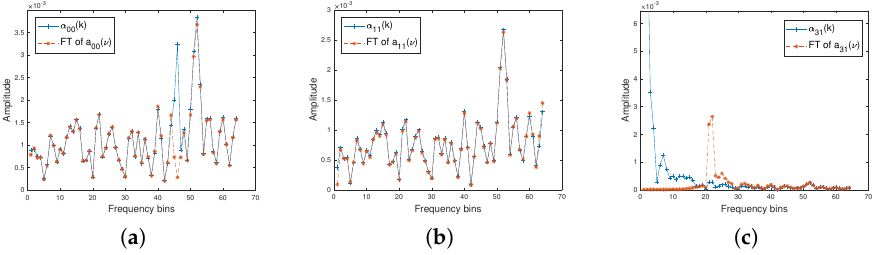
Figure 6. Amplitude comparison between the Fourier Transform of the time domain spherical harmonic coefficients a nm ( ν ) and frequency domain spherical harmonic coefficients α nm ( k ) at mode ( a ) 00, ( b ) 11 and ( c ) 31 with a white Gaussian